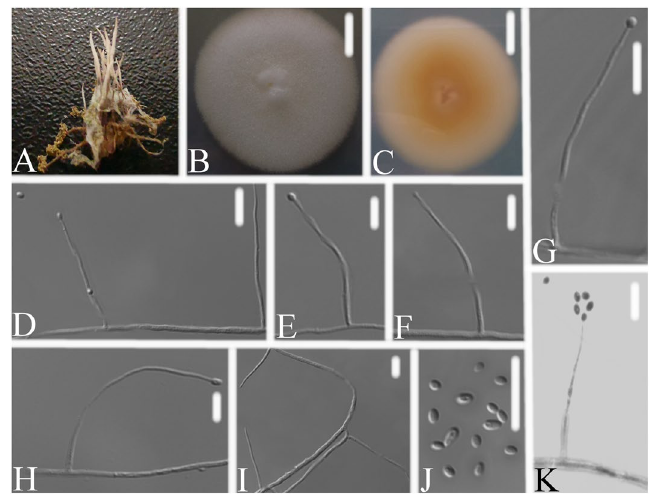
Figure 4. Simplicillium hymenopterorum (A) infected ant (Hymenoptera) (B,C) culture plate, showing the front (B) and the reverse (C) of the colony, cultured on PDA medium (D–I) , (K) phialides solitary, conidia adhering ellipsoidal slimy head and conidia (J) conidia. Scale bars: 10 mm (B,C) , 10 μm (D–K) .